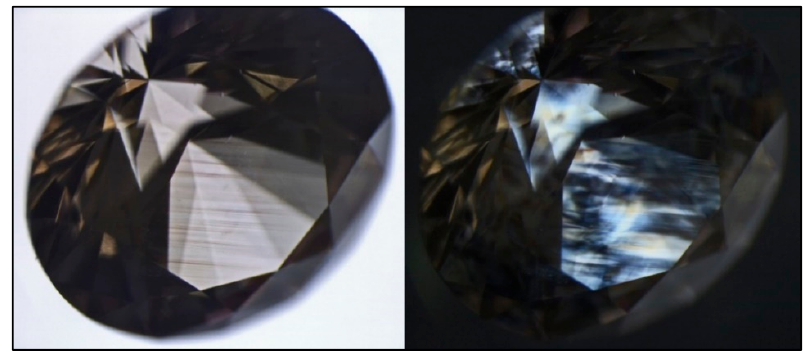
Figure 3. A brown hydrogen-rich type IaB diamond (sample TH 2.619) that clearly shows its color being caused by deformation-related brown color lamellae (left, immersion) along the octahedral crystal directions; the characteristic extinction patterns following the brown lamellae (“graining”) can be seen on the right (immersion, crossed polarizers).